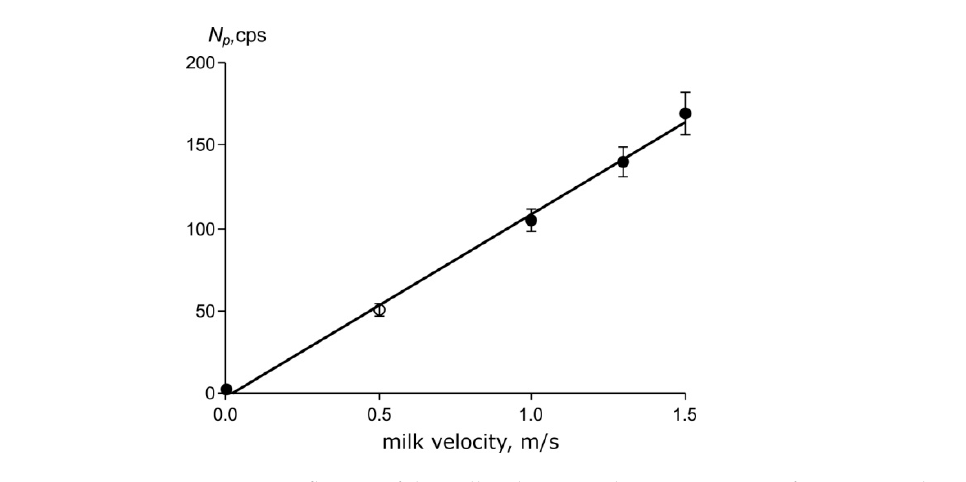
( d ) Figure 10. Oscillogram screenshots for different milk flow velocities: ( a ) 0 m/s; ( b ) 1.0 m/s; ( c ) 1.3 m/s; ( d ) 1.5 m/s. The response pulses should be counted at a threshold discrimination of non-informa- tive noise. As can be seen from the oscillograms of recorded signals (Figure 10), small- sized impulse emissions most likely correspond to optical extinction on small fat globules, and sharp peaks in the minus region are mainly associated with the presence of large fat globules. When milk moves along the milk pipe, these minus peaks change the frequency of their appearance. Based on the recorded waveforms (similar to those in Figure 10), we have plotted a graph (Figure 11) that illustrates a direct correlation between the flow velocity and the